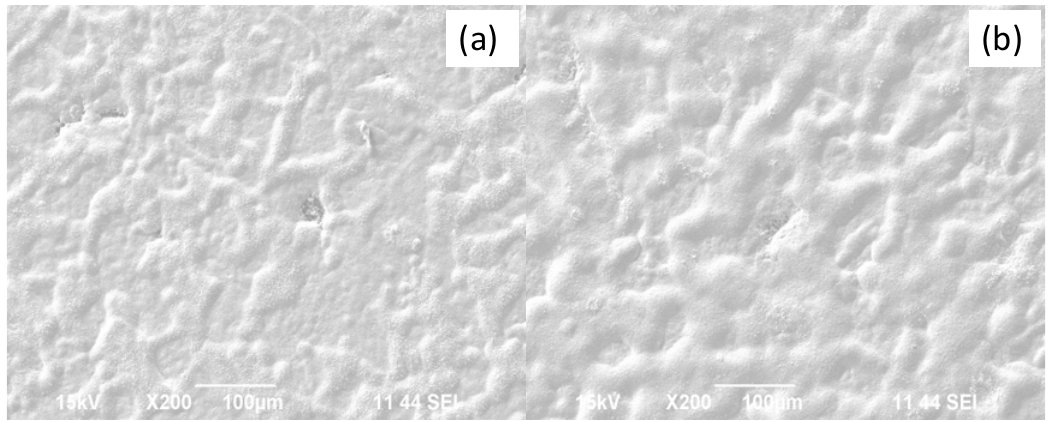
Figure 5. SEM images of the IC surface morphologies oxidized in humid air at ( a ) 650 °C and ( b ) 700 °C.